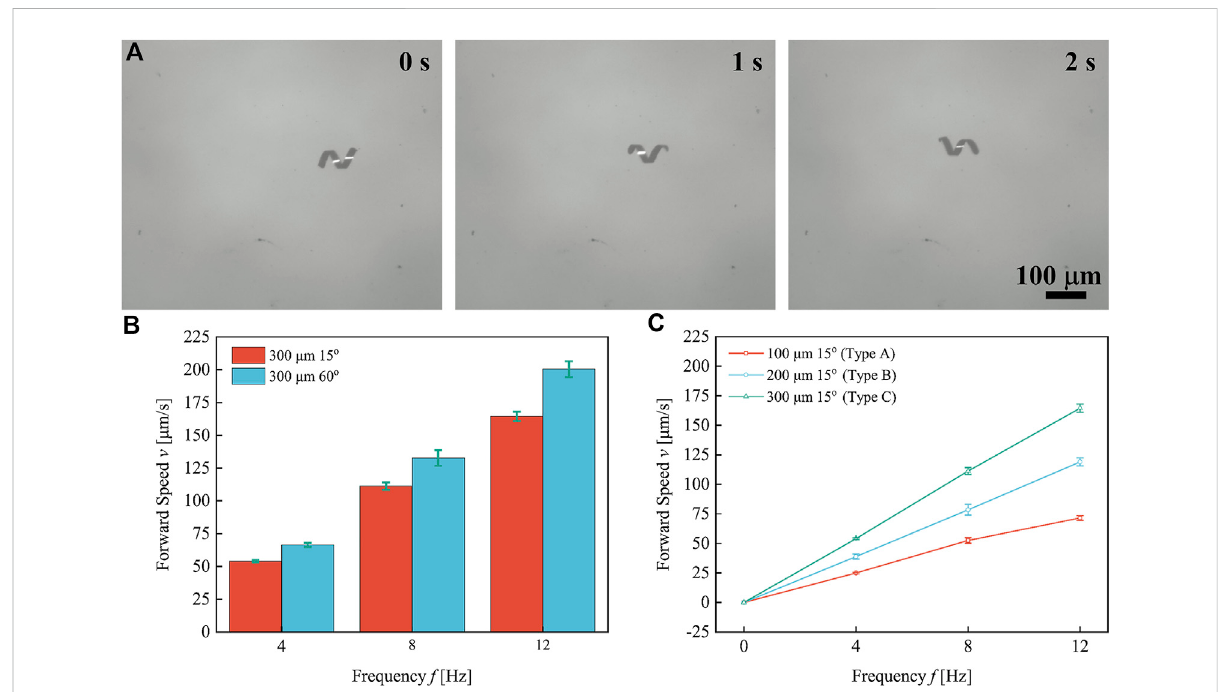
FIGURE 3 Forward swimming speed of helical microrobots under different rotational frequencies. (A) The time-sequence swimming of the helical microrobot fabricated through the parallelogram templates with the length of 300 μ m and tilt angles of 60 ° under the rotational frequency of 4 Hz. (B) The forward swimming speed of helical microrobots with different helical angles versus frequency. (C) The forward swimming speed of helical microrobots with different body lengths versus